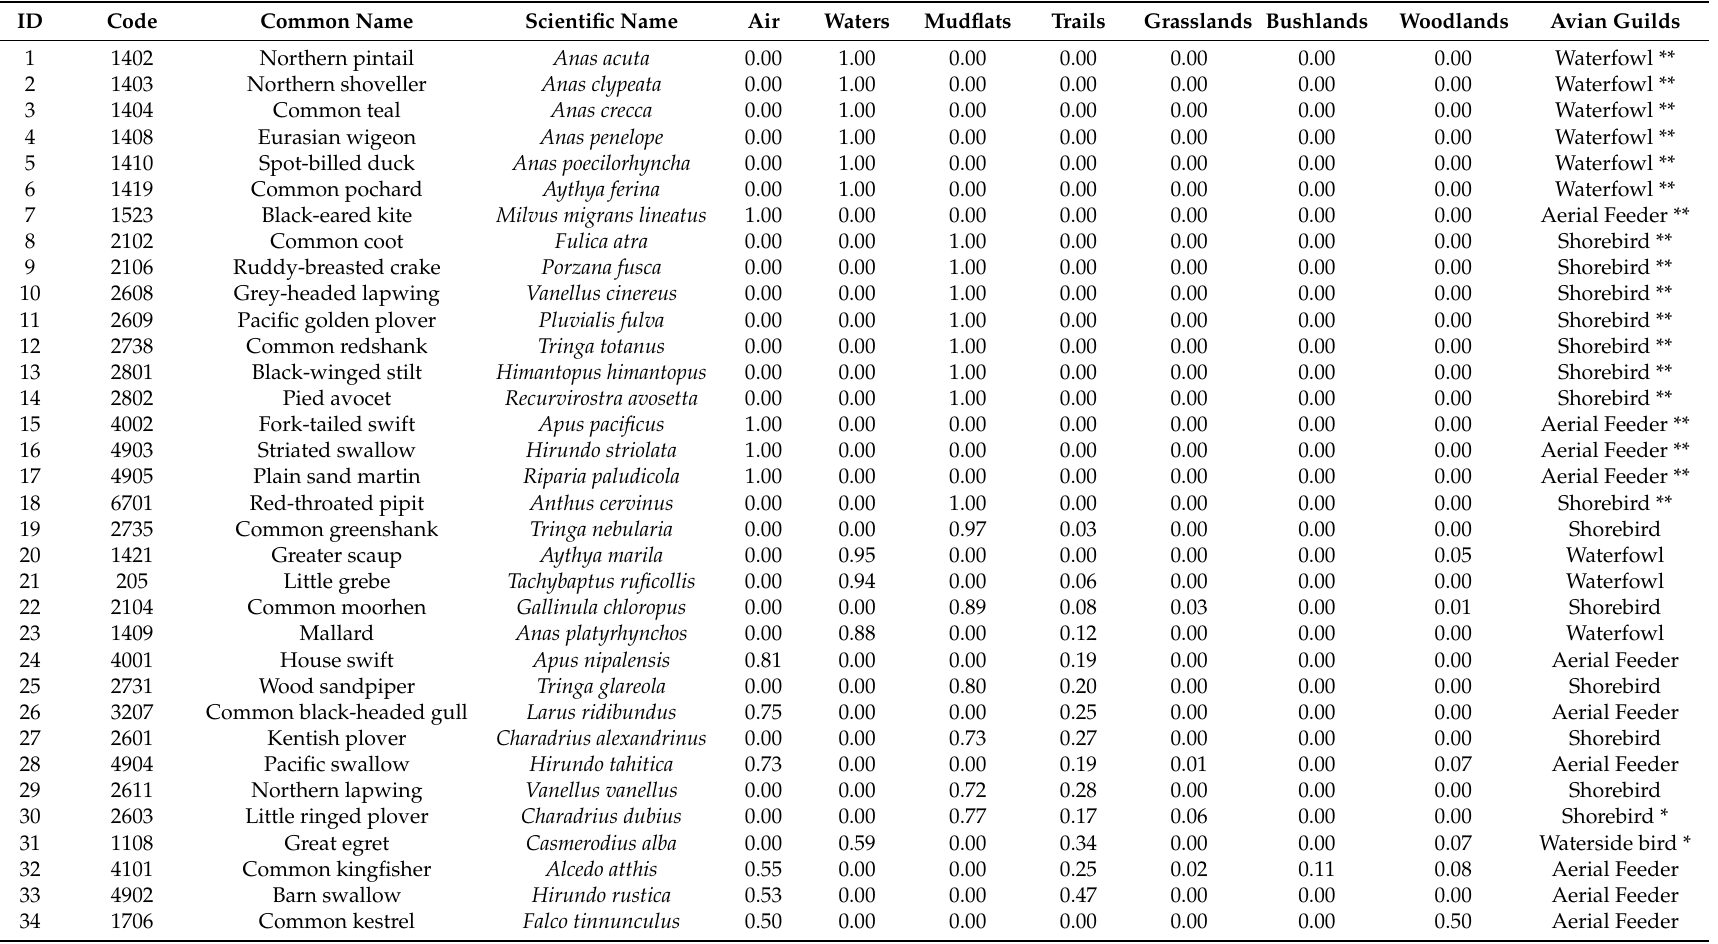
Table A1. List of birds detected in Taoyuan farm ponds and their occurrence rate in different